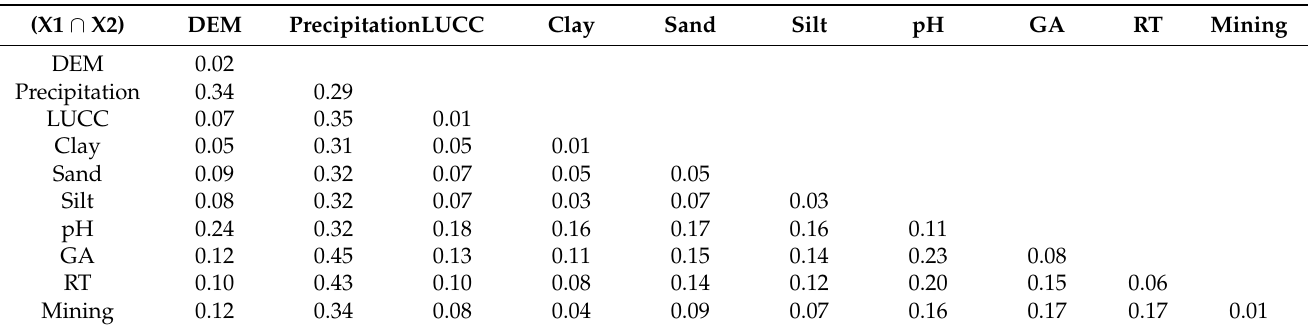
Table 7. Effects of the interaction between each pair of driving factors on the enrichment of the Pb concentration in the YTRB.